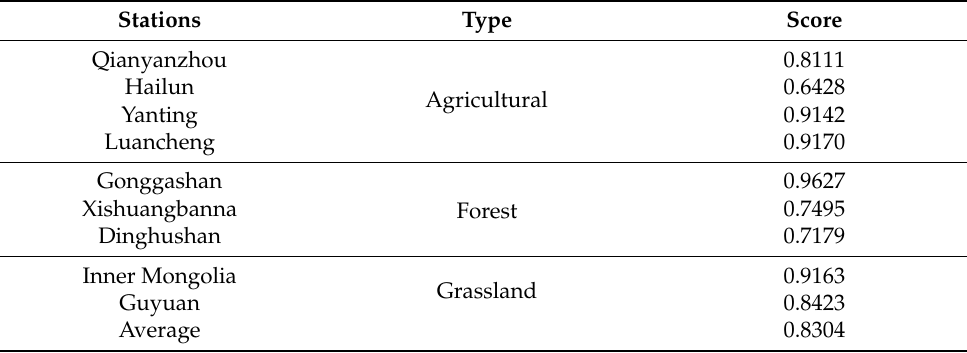
Table 4. Scores of test stations by DSS-LPV based on Random